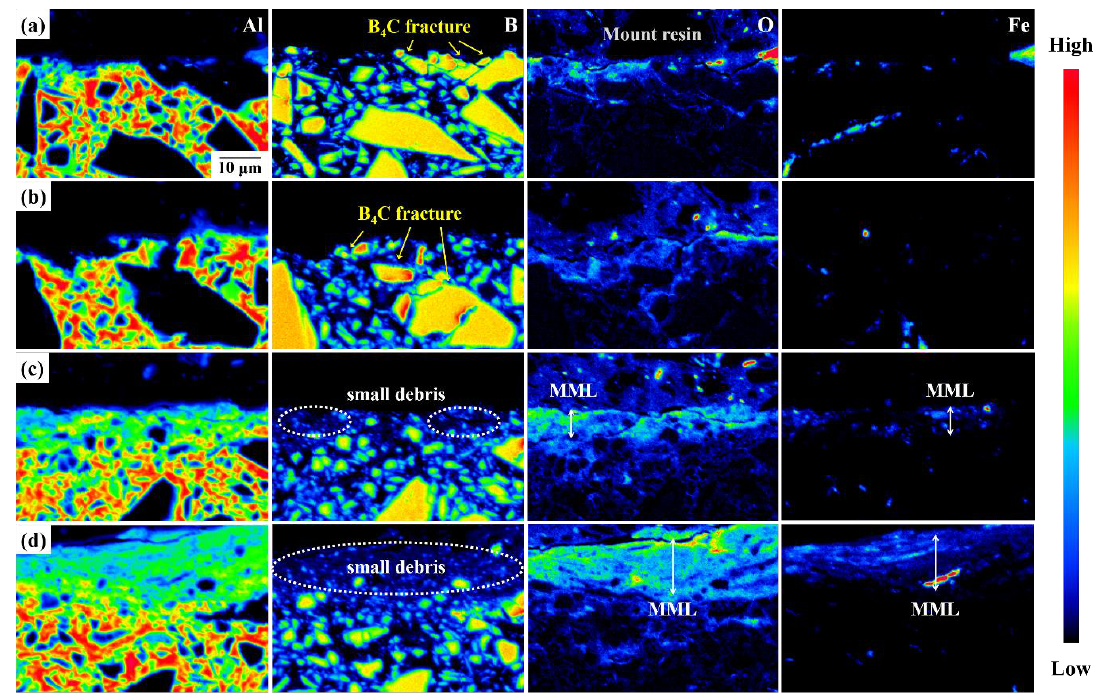
Figure 7. Cross sectional electron probe micro analyzer (EPMA) analysis images after the wear test(same magnification): ( a ) room temperature, ( b ) 100 °C, ( c ) 200 °C, and ( d ) 300 °C.